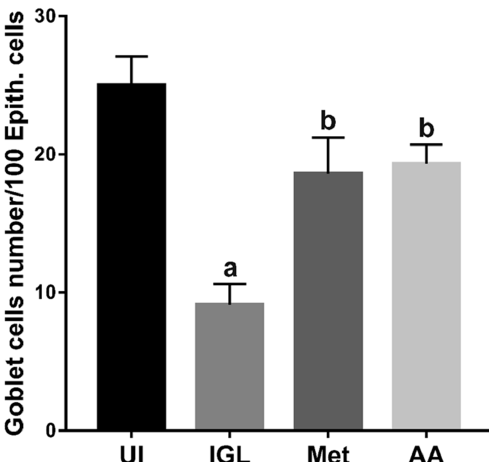
Figure 8. Treatment with A. annua restored goblet cell numbers in small intestine of infected hamsters . Images of intestinal tissues stained with PAS and hematoxylin were used to count goblet cells. A. annua extract significantly increased the goblet cell number compared to infected untreated animals (AA versus IGL). A. annua effect was comparable to that of metronidazole. “ a ” indicates significant difference versus UI group and “ b ” indicates significant difference versus IGL group ( p < 0.001). Data are means ± SD (n = 3) and were analyzed using ANOVA test with Bonferroni corrections as a post hoc